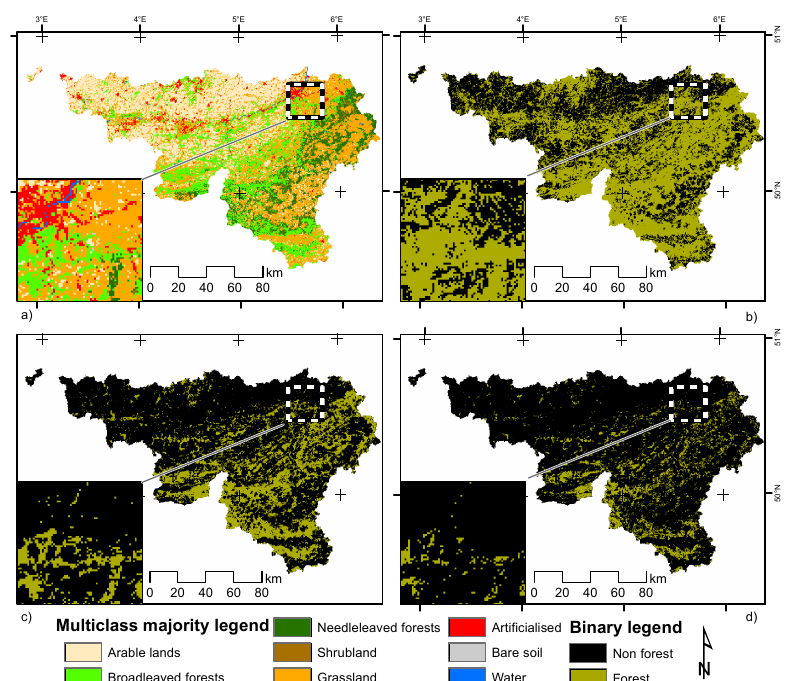
Figure 2. Maps of the study area based on majority classification system ( a ) and the different binary classification systems for the forest classes: 10% for top right ( b ); 50 % for bottom left ( c ) and 75% for bottom right ( d ).